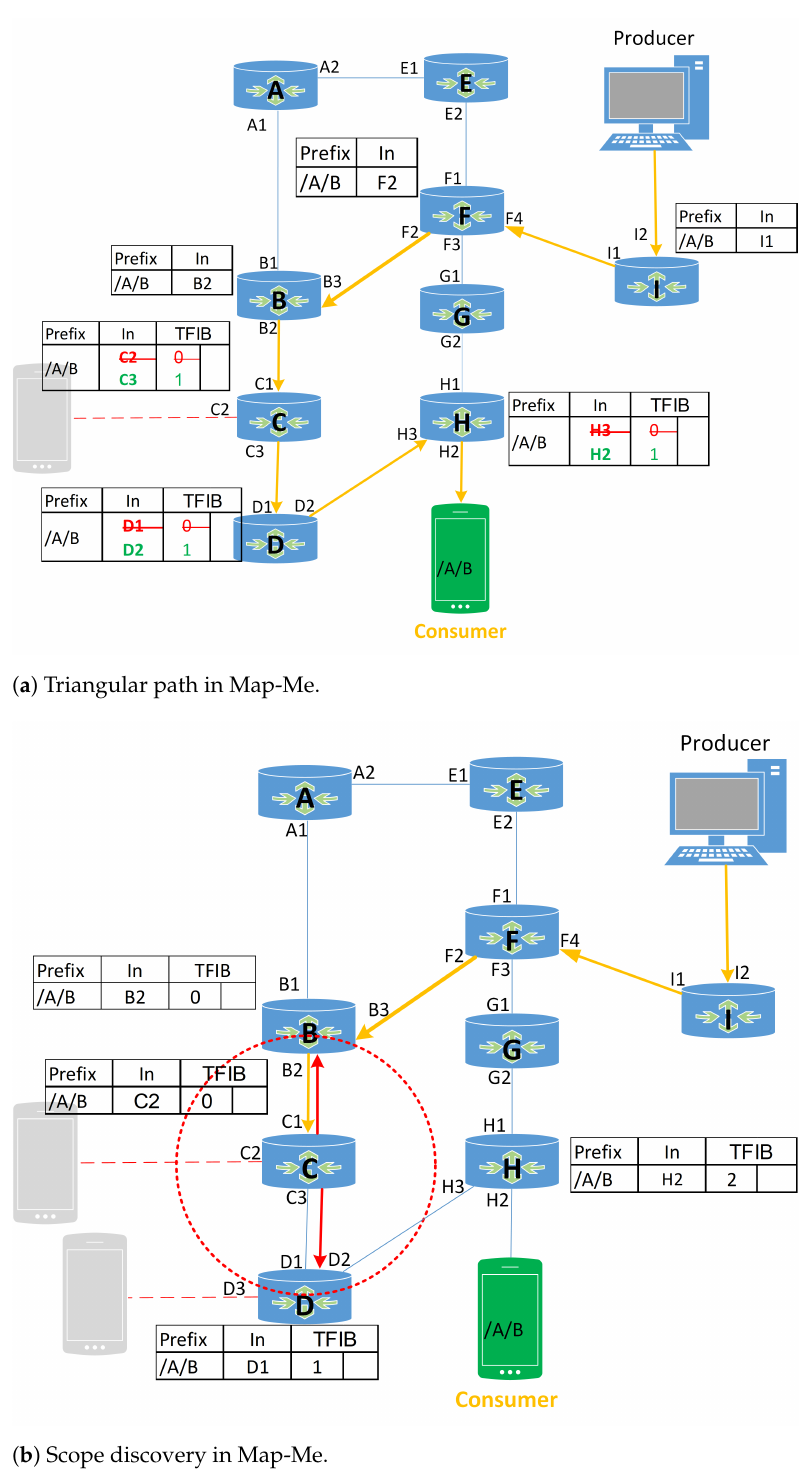
Figure 3. Example Map-Me